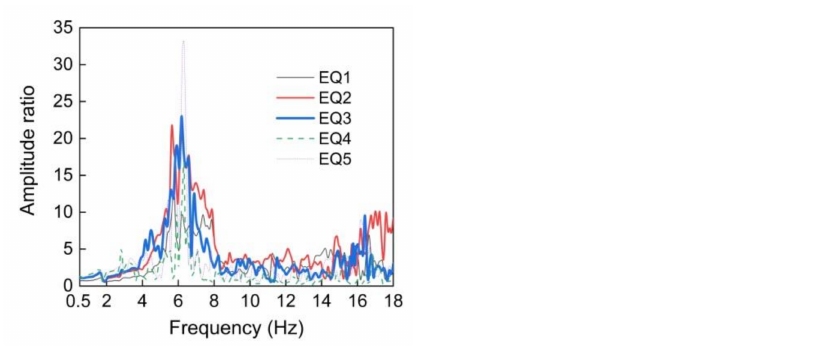
Figure 5. The amplitude ratios of the transfer function of the acceleration measured at A-3 (slope crest) and A-0 (bottom of the model box) in the 1#model during centrifuge testing.